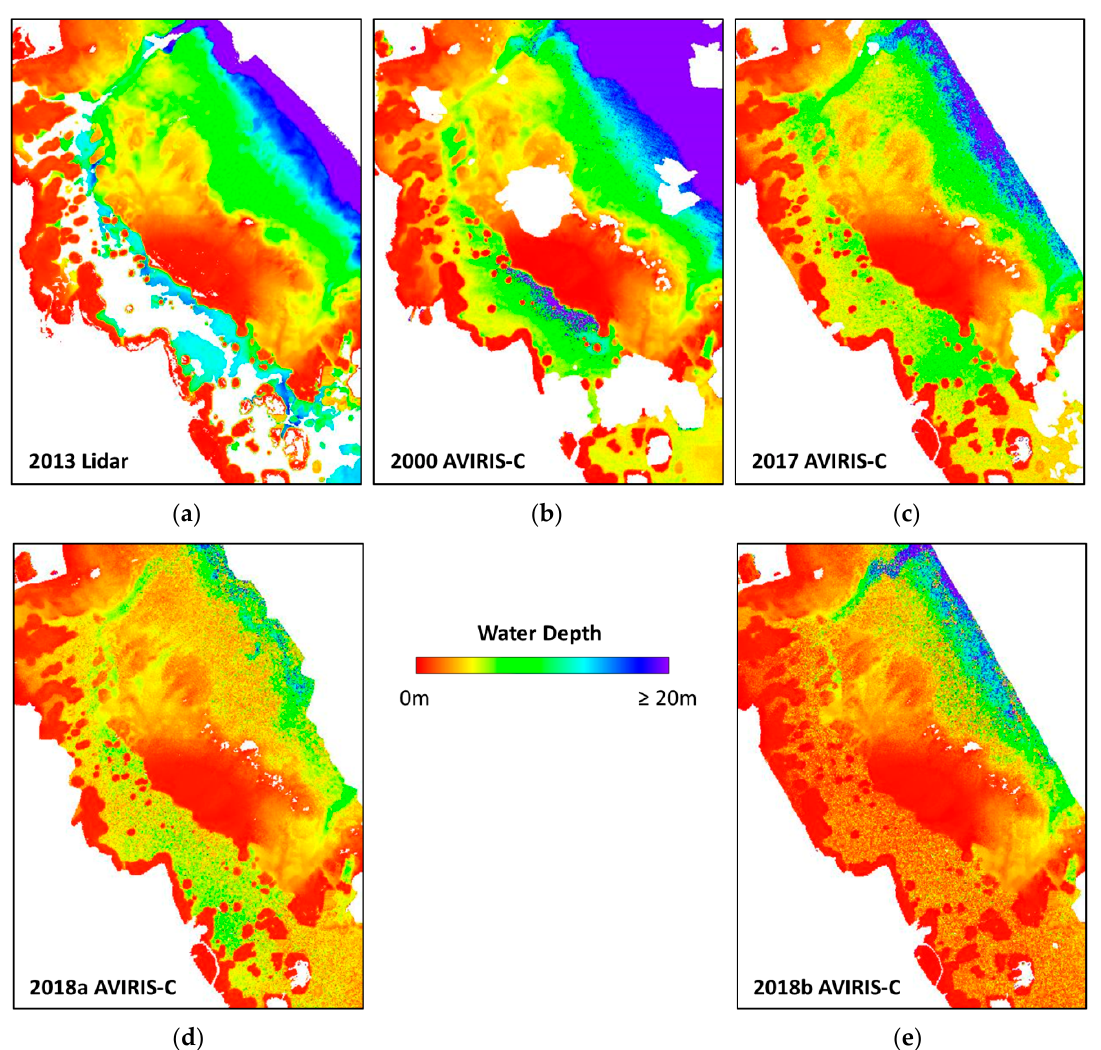
Figure 3. Derived bathymetry output for Kaneohe Bay at 18 m spatial resolution: ( a ) 2013 lidar bathymetry; ( b ) 2000 AVIRIS-C derived water depth; ( c ) 2017 AVIRIS-C derived water depth; ( d ) 2018a AVIRIS-C derived water depth; ( e ) 2018b AVIRIS-C derived water depth. Areas with no data and masked areas of land, cloud, cloud shadow, and wave breaks are shown in white.